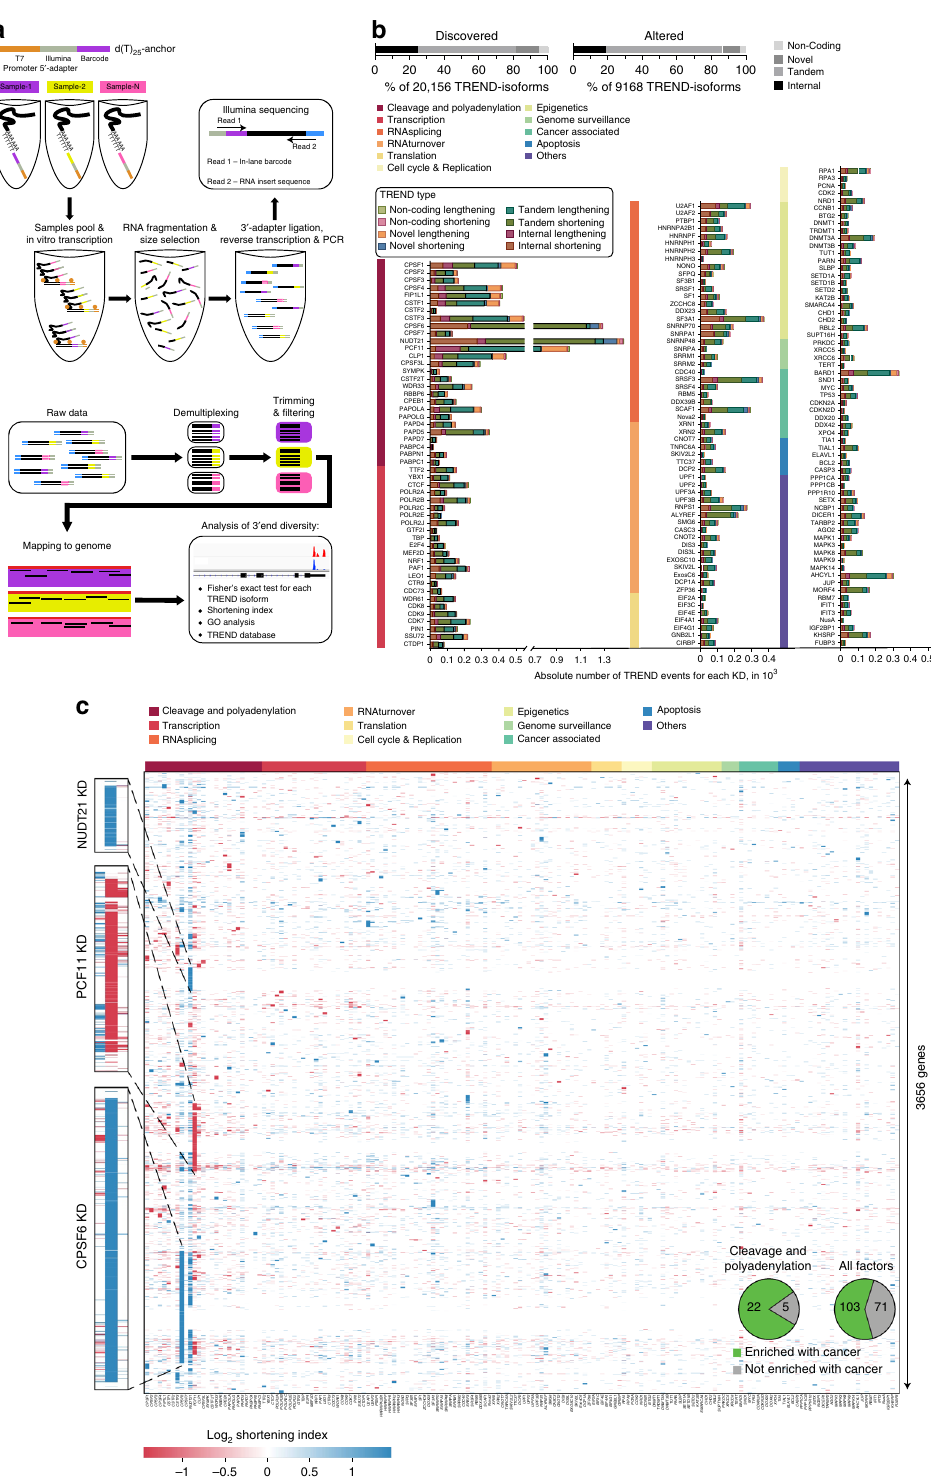
important role in basic cellular programmes, including a potential function in tumorigenesis (Supplementary Table 2, cancer enrichment score 2.98 × 10 − 9 , Supplementary Figure 6a). To further substantiate this in the context of neuroblastomas, we pro fi led the proteome of BE(2)-C cells upon PCF11-depletion using mass spectrometry. We identi fi ed 5903 proteins out of which 330 showed a regulation of more than 1.5-fold ( p -value < 0.05). Merging this with the data set of APA-regulated